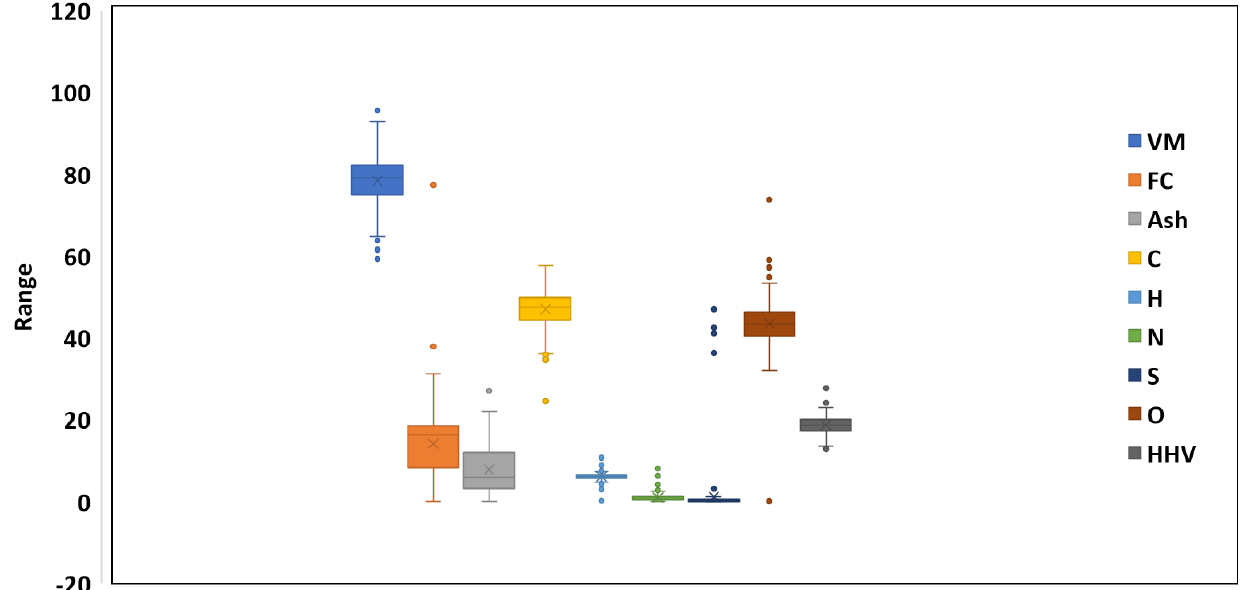
Figure 4. Box plot results of the statistical analysis of the input features and target (HHV) obtained from the entire dataset used in the machine learning models.